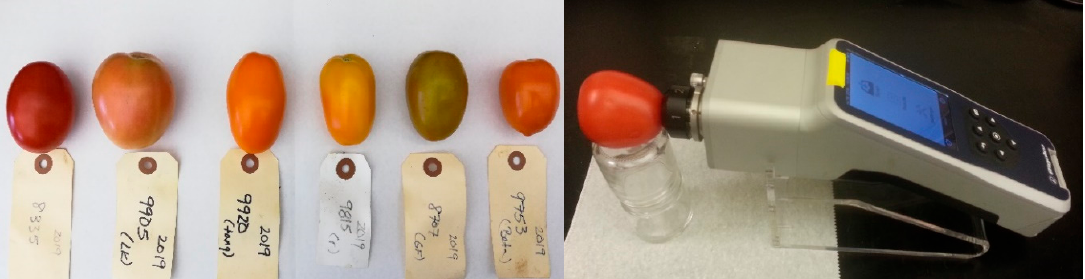
Figure 1. Tomato samples and surface scan using Rigaku’s Progeny handheld Raman